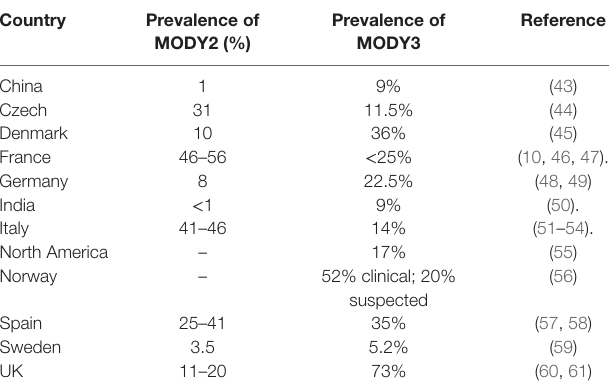
TAbLe 2 | Prevalence of MODY2 and MODY3 in different countries. Country